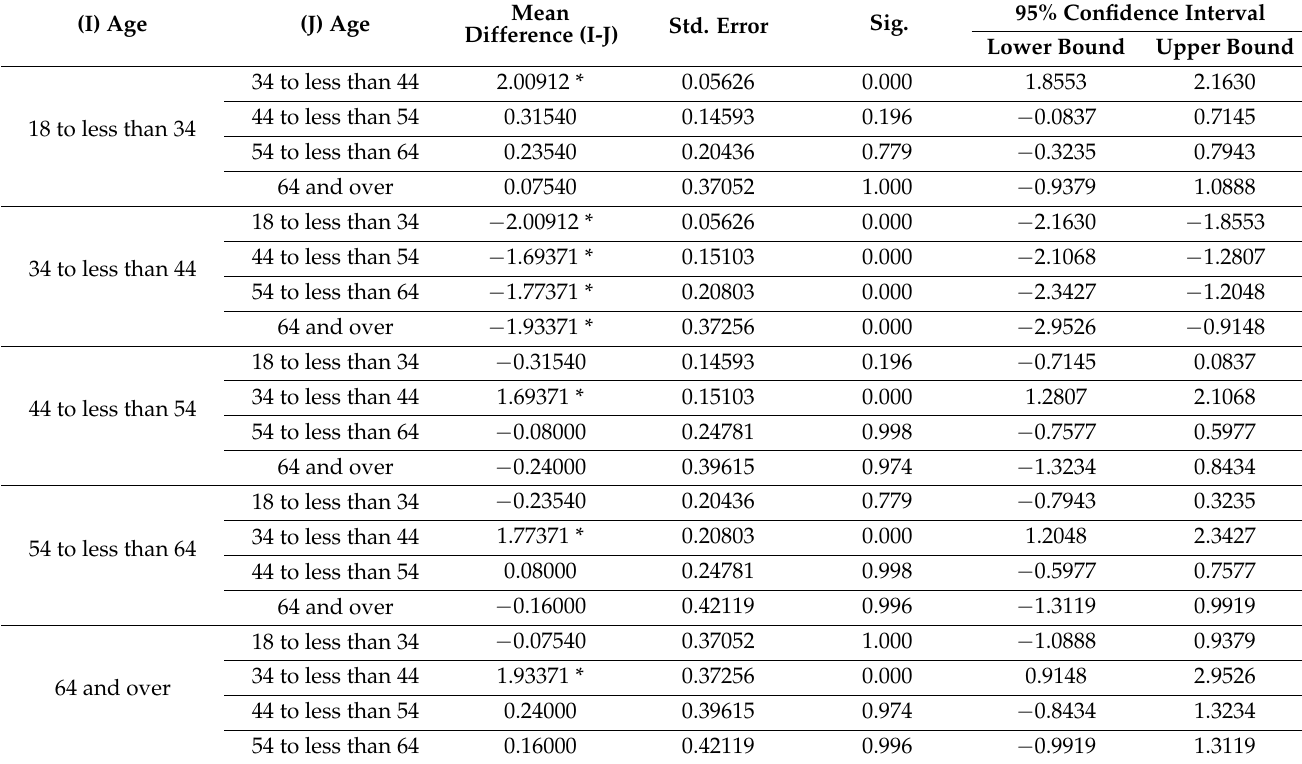
Table 10. Multiple comparisons analysis of the information adoption (IA) attributed to